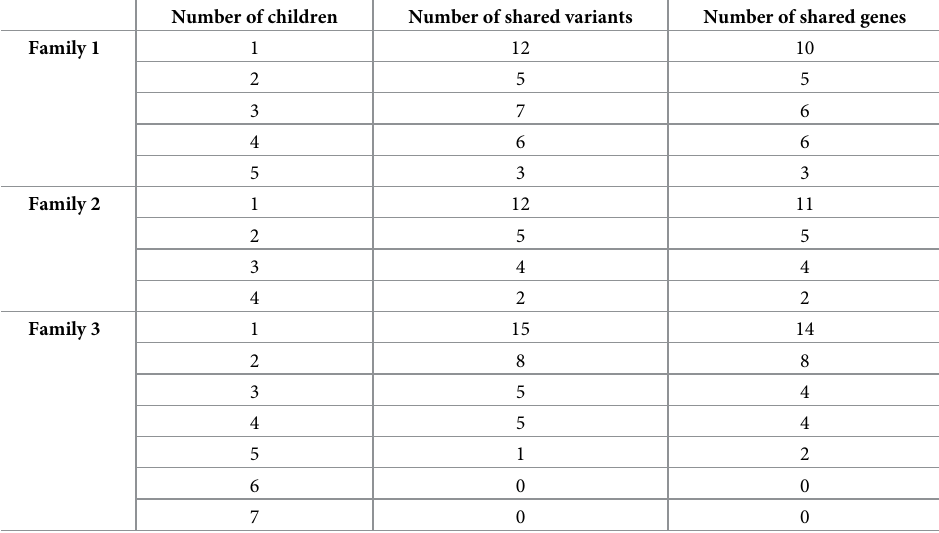
Table 1. An overview of variants in common among children within each nuclear family.